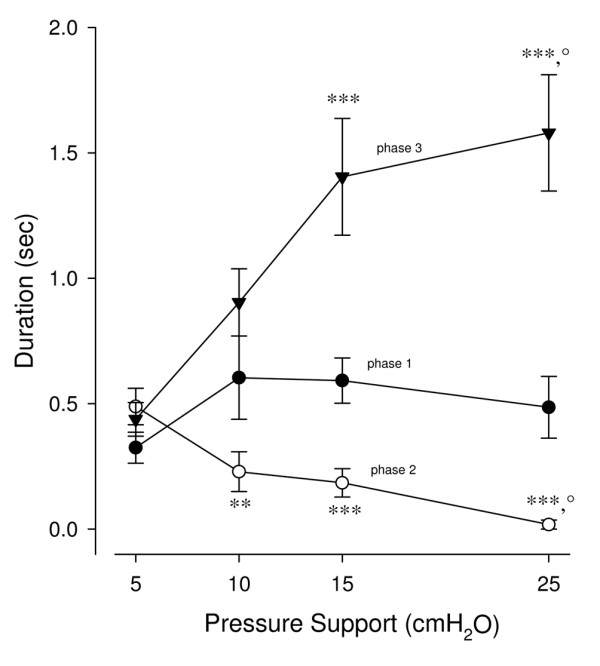
Relationships between pressure support levels and duration of the various phases of inspiration. The phases (phase 1 [closed circles], phase 2 [open circles] and phase 3 [closed triangles]) are defined in the text. Data are expressed as mean ± standard error of the mean. **P < 0.01, ***P < 0.001, versus pressure support = 5 cmH2O. °P < 0.05, versus pressure support = 10 cmH2O.